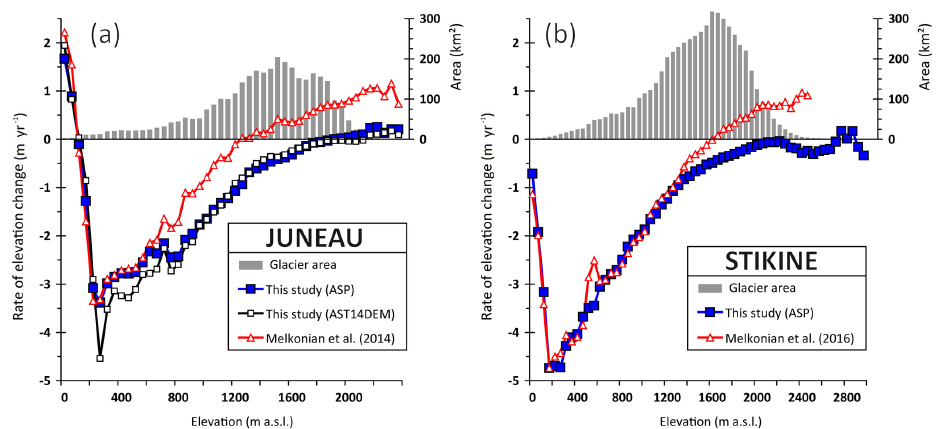
Figure 2. Rates of elevation change vs. elevation for the JIF from 2000 to 2013 (a) and for the SIF from 2000 to 2014 (b) . Results from this study are compared to the d h/ d t values obtained in two earlier studies using a similar method (Melkonian et al., 2014, 2016). The grey histograms show the area–altitude